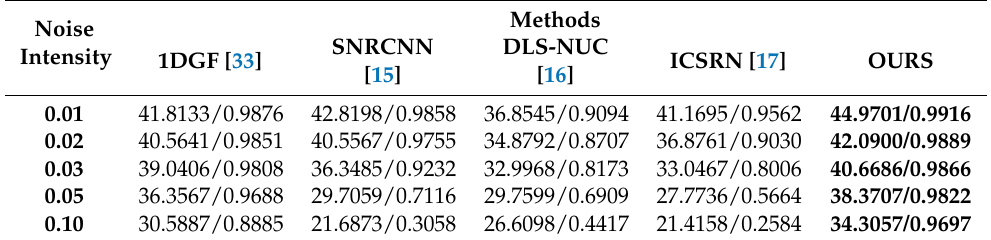
Table 1. Mean PSNR (dB)/SSIM results of different methods on 100 simulated noise infrared images.